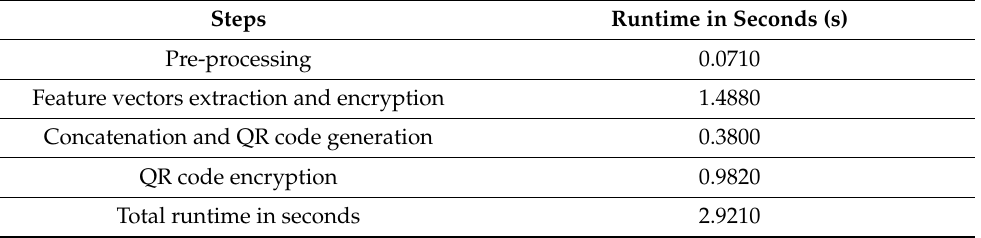
Table 1. Average execution time of the proposed scheme’s steps.